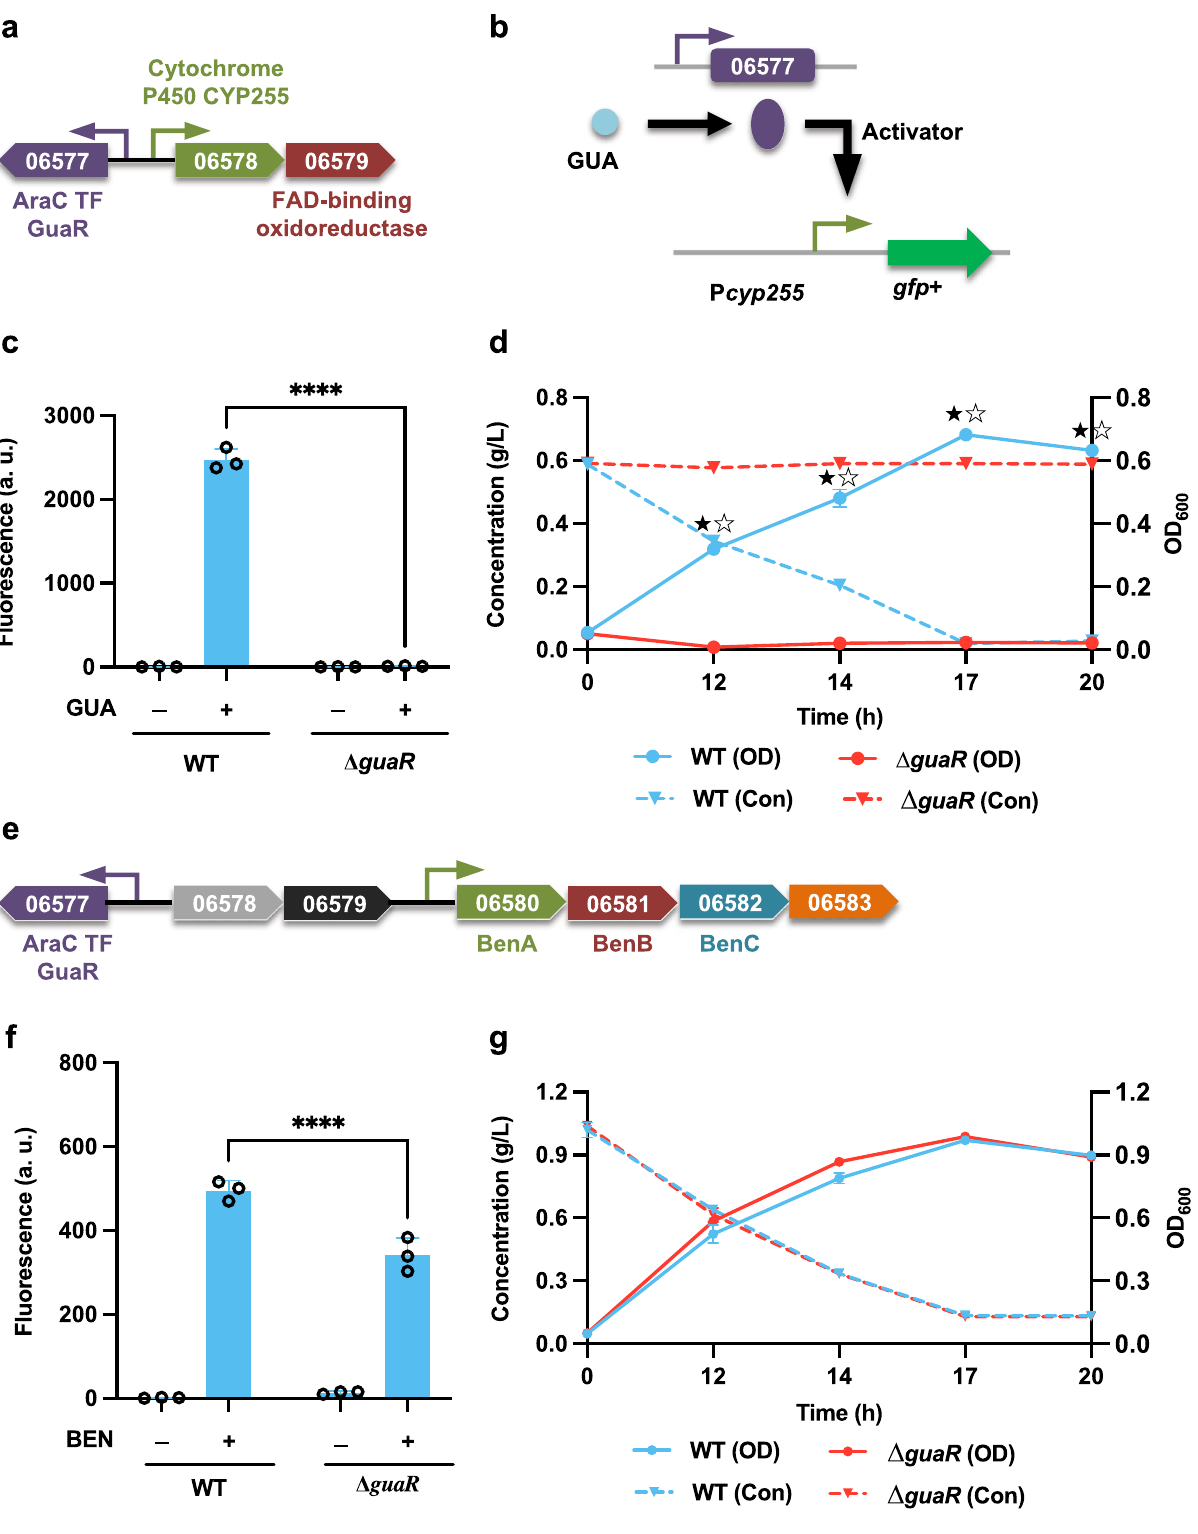
short overlap region in the C terminus. The phenotype of Δ vanR2 , which was created with vanR1 intact, is characterized in part by the negative effect on the expression of vanR1 , an effect which may be explained by the gene deletion causing unexpected context effects on neighboring genes 36 . Taken together, these fi ndings suggest that vanR1 is a key activator that regulates the vanillate funneling pathway in R. opacus